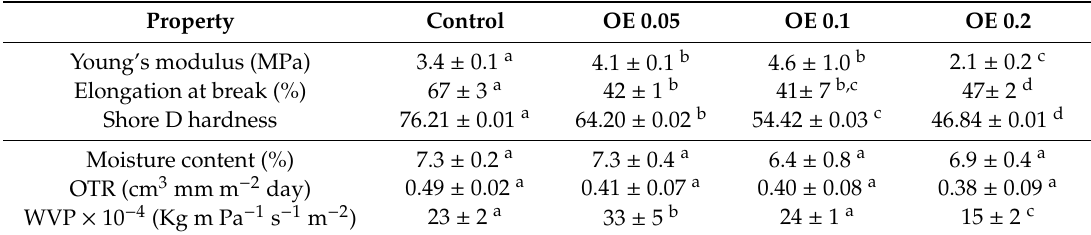
Table 3. Mechanical ( n = 5) and barrier ( n = 3) parameters obtained for edible films. Mean ±